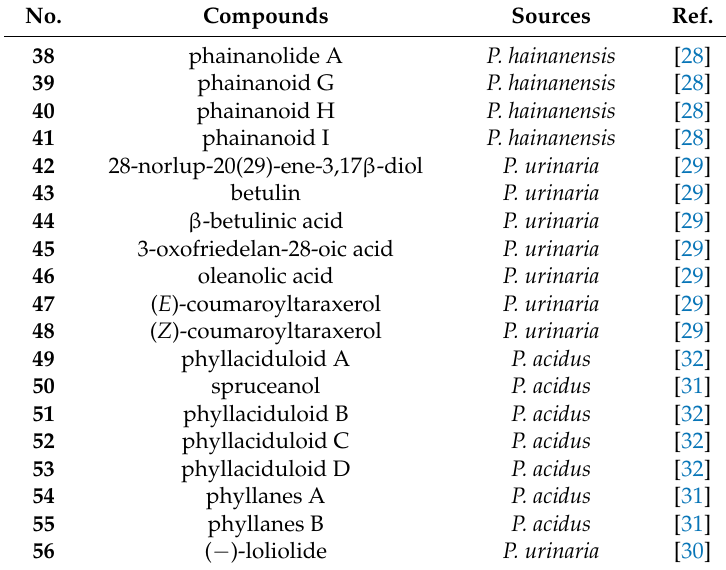
Table 2. Structures and sources of terpenoids from various Phyllanthus